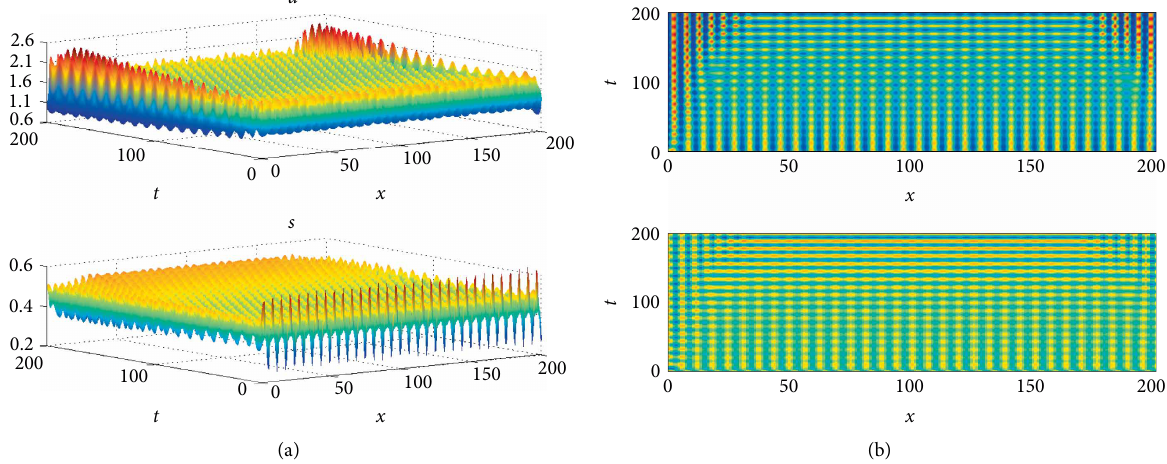
Figure 6: (a) The stable limit cycle of (4) becomes unstable for (3) for (𝑥, 𝑡)